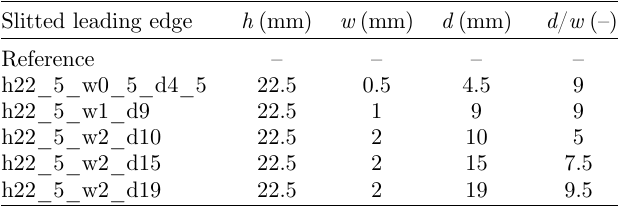
Table 2. Geometrical parameters of slitted fans